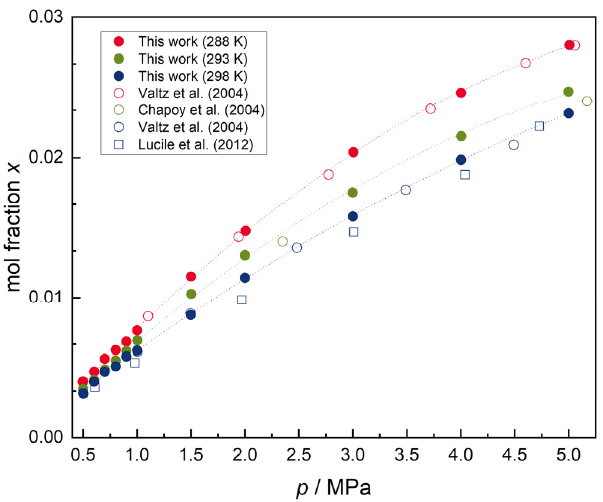
Figure 3. Solubility of carbon dioxide in water at T = (288.24, 293.31, 298.16) K, respectively. Literature date are reported in references [4–6]. Uncertainty values are not shown for clarity but are provided in Appendix A.